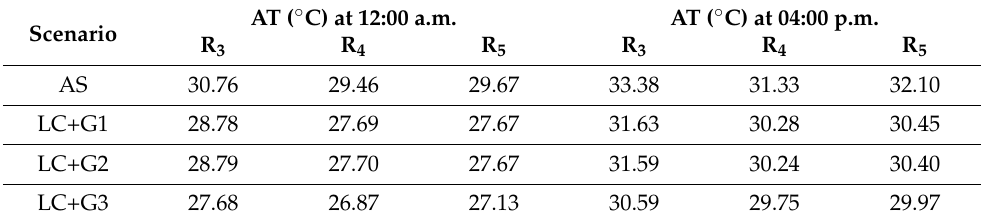
Table 5. AT values at 12:00 a.m. and 04:00 p.m. AT ( ◦ C) at 12:00 a.m. AT ( ◦ C) at 04:00 p.m. Scenario R 3 R 4 R 5 R 3 R 4 R 5 AS 30.76 29.46 29.67 33.38 31.33 32.10 LC+G1 28.78 LC+G2